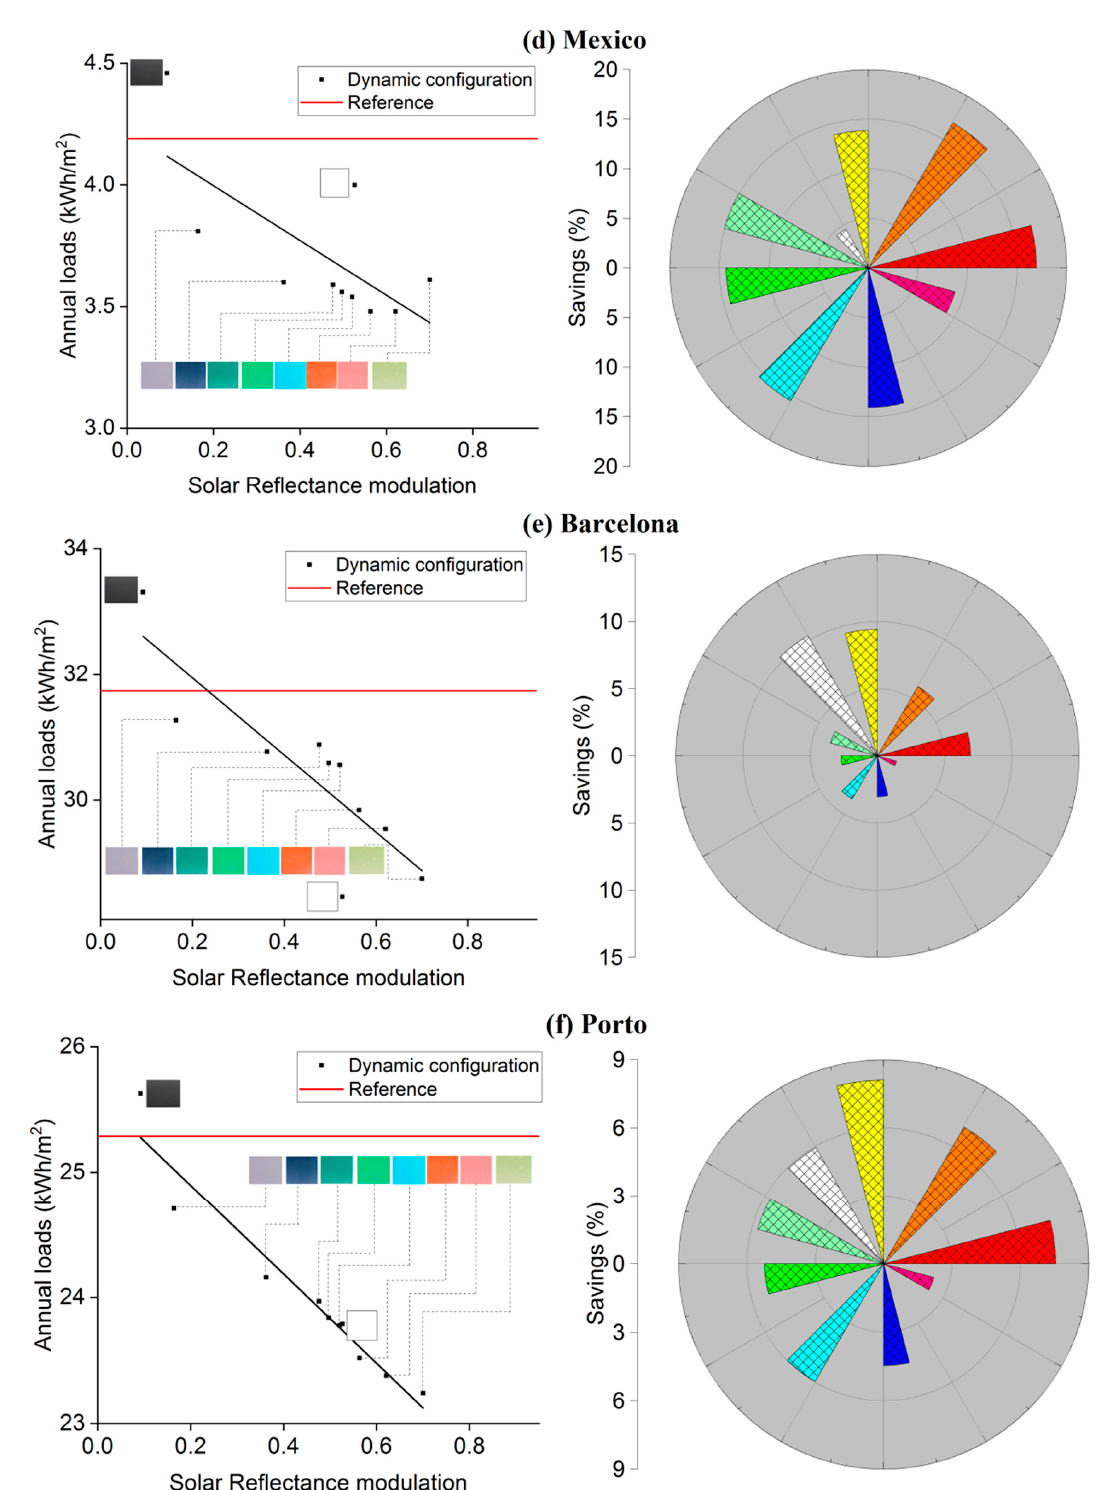
Figure 6. HVAC load savings in climate C (Temperate): ( a ) Atlanta, ( b ) Paris, ( c ) Sao Paulo, ( d ) Mexico, ( e ) Barcelona and ( f ) Porto.